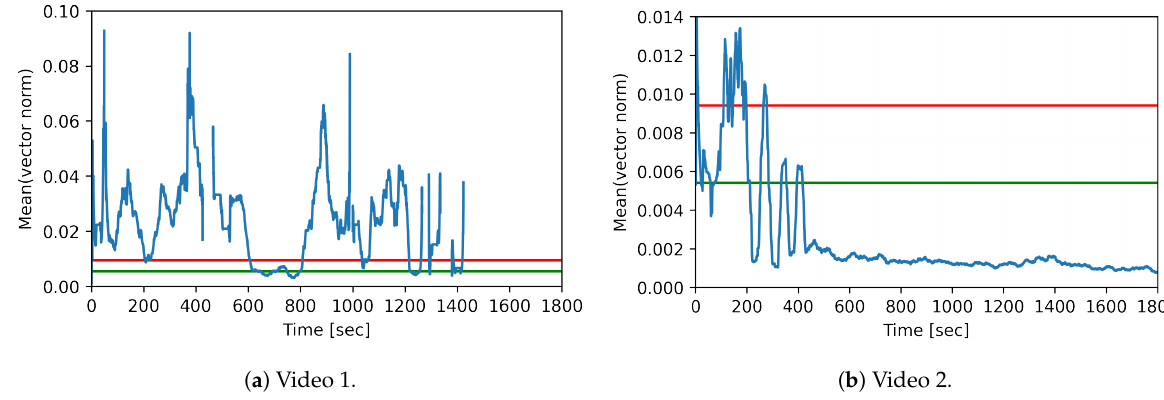
Figure 7. Movement pattern for videos 1 and 2: mean vector norm for 30 sliding window over time, with the thresholds for activity level differentiation. Green: inactive ↔ active. Red: active ↔ high active.